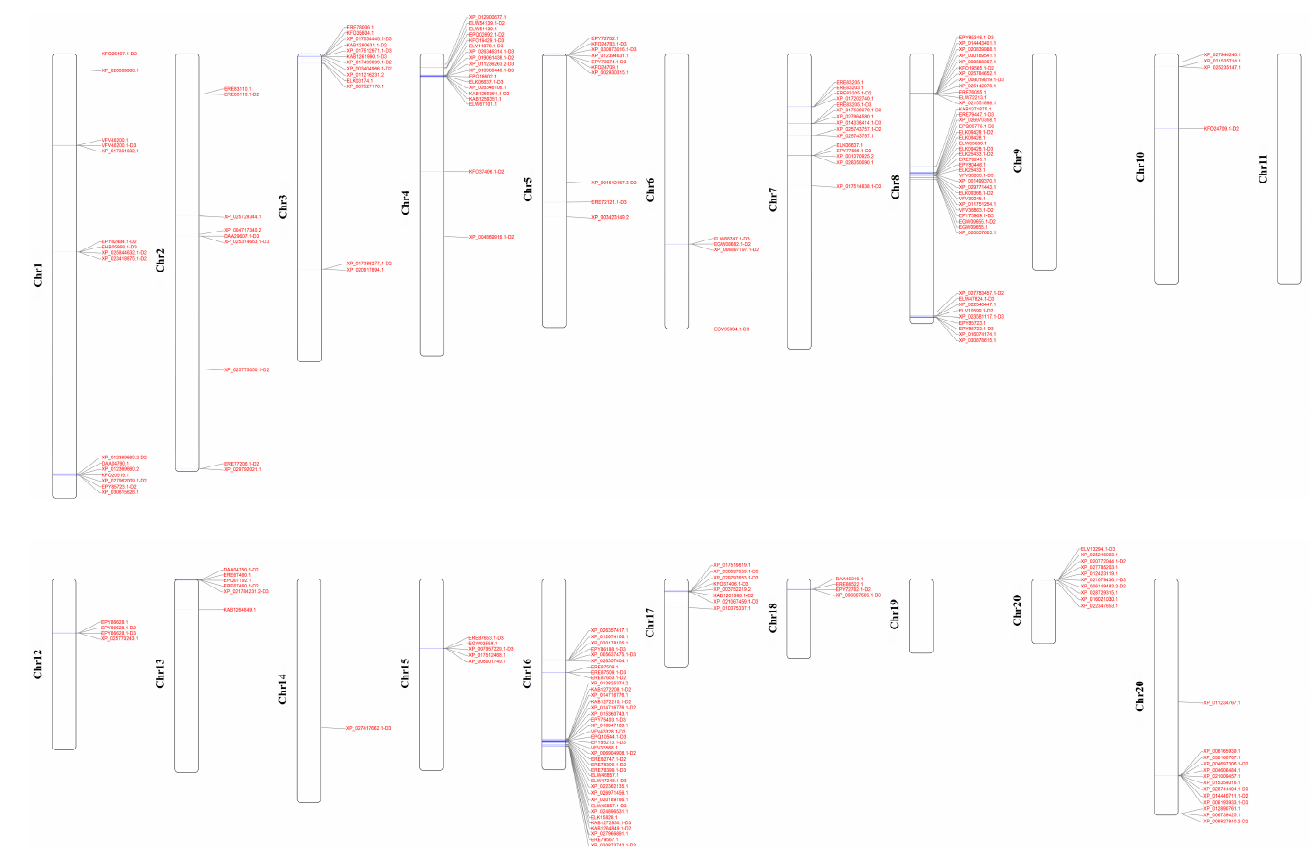
Figure 3. Chromosomal distribution of the functional OR genes of the giant panda. Table 2. Composition of OR genes for each chromosome of the giant Table 1. Summary of the olfactory receptor (OR) genes in six Ursidae species.